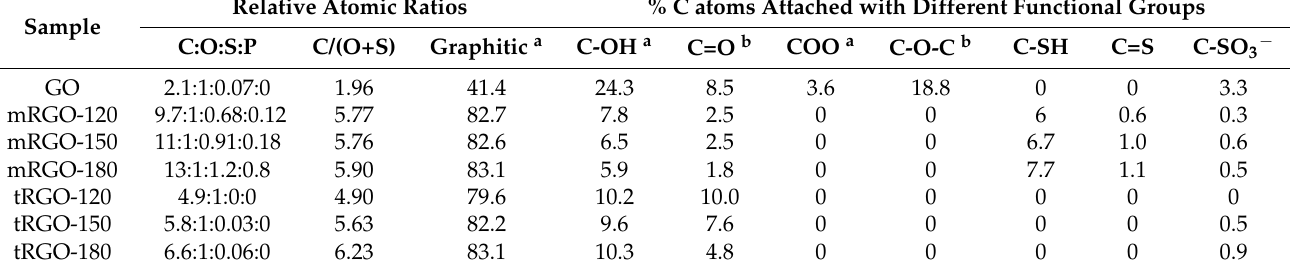
Table 1. Relative atomic ratios and the amounts of functional groups in GO, mRGO, and tRGO prepared at different reaction